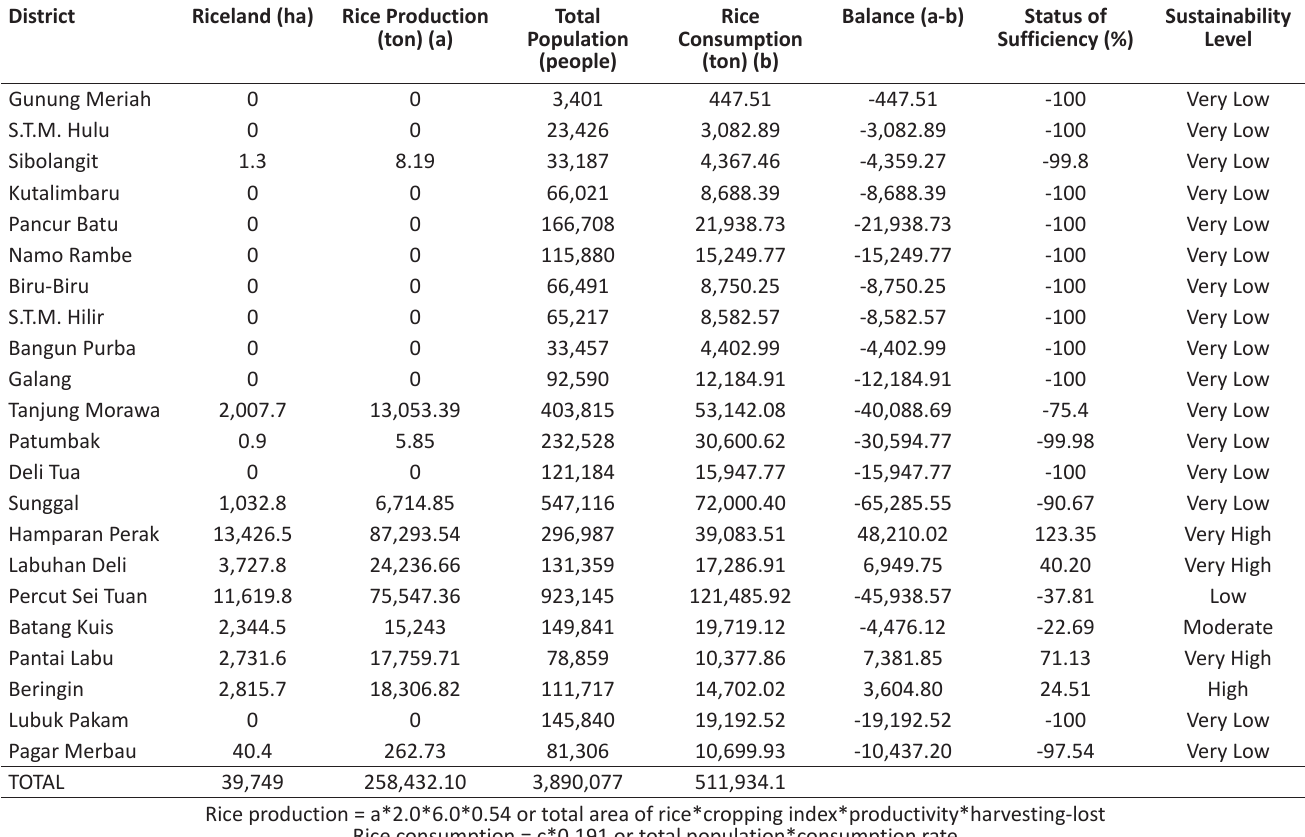
Table 5 . Rice production sustainability of Deli Serdang Regency by 2040 based on BAU scenario.